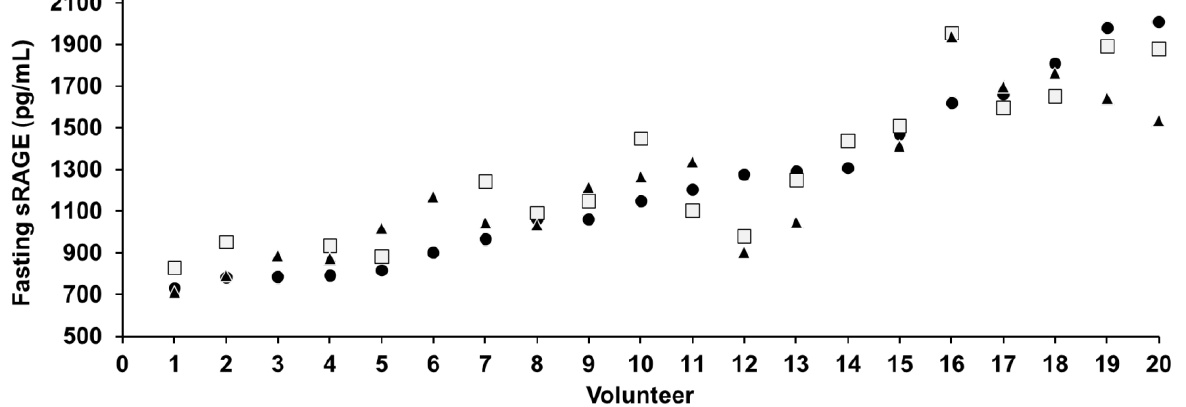
Figure 3. Distribution of fasting plasma sRAGE levels among the 20 volunteers prior to the 3 different interventions (● time 0, □ +7 days, ▲ +14 days). Among the 4 adducts measured in the plasma of the 20 volunteers before